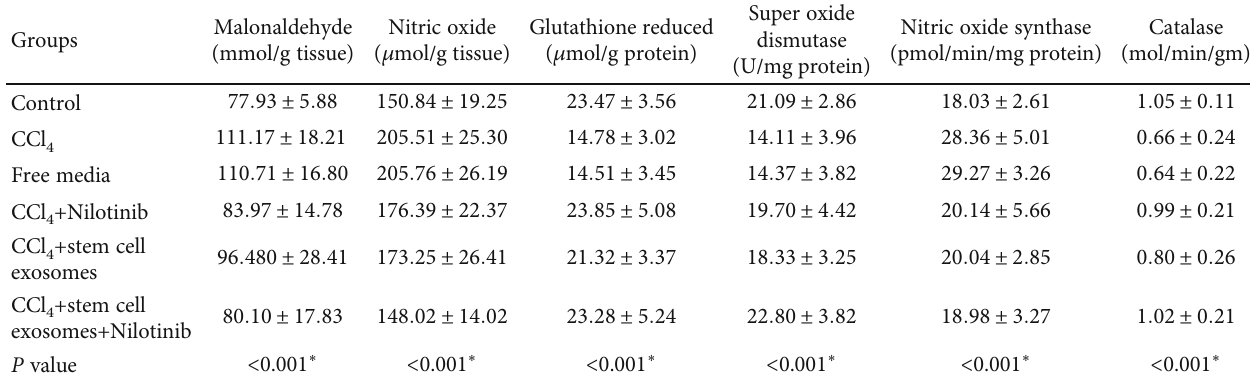
Table 3: Oxidative stress markers among the studied groups.